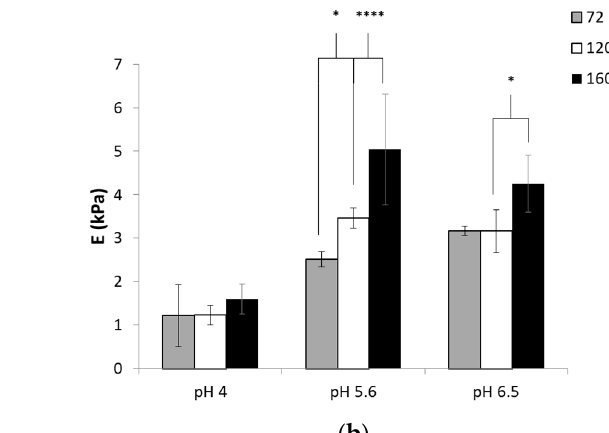
Figure 4. Kinetic analysis was performed using Ellman’s reagent representing the thiol concentration in gel vs. time. The bars represent the standard error of the mean, n = 3.